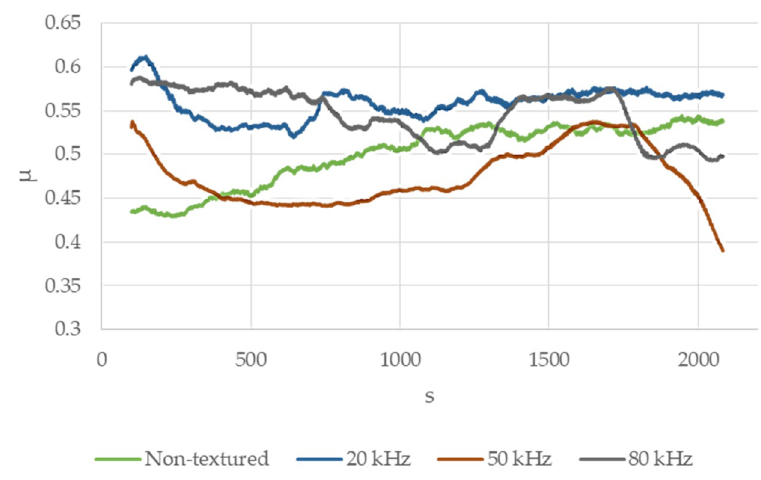
Figure 5. Friction coefficient evolution as a function of sliding time ( V s = 10 mm/s).